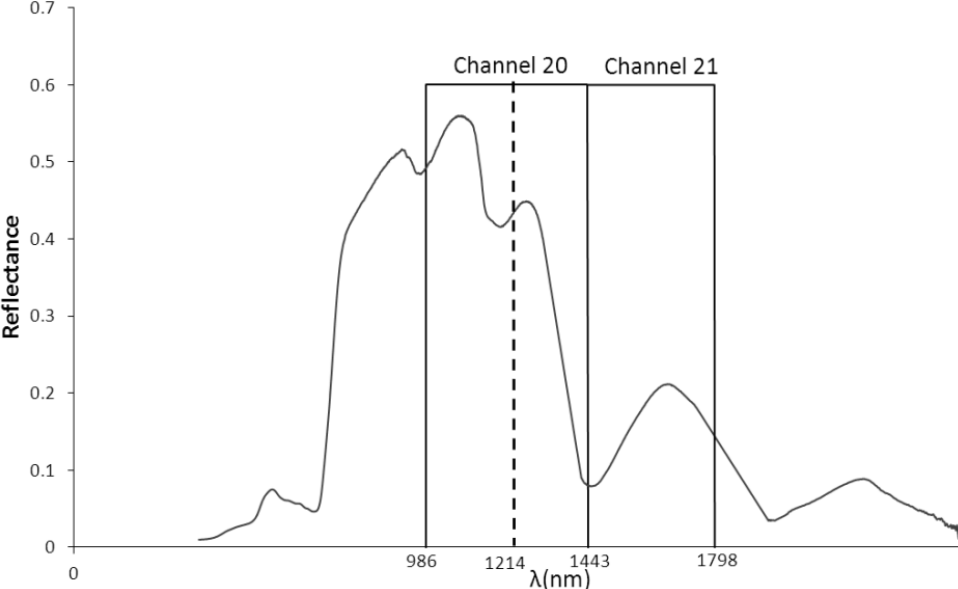
Figure 4. Spectral width attributed to channels 20 and 21 of AHS in the integration of HDRF to obtain the broadband albedo. A typical vegetation spectral signature is shown. The wavelength 1214 nm would have been the limit between both channels if a mere linear interpolation had been considered.